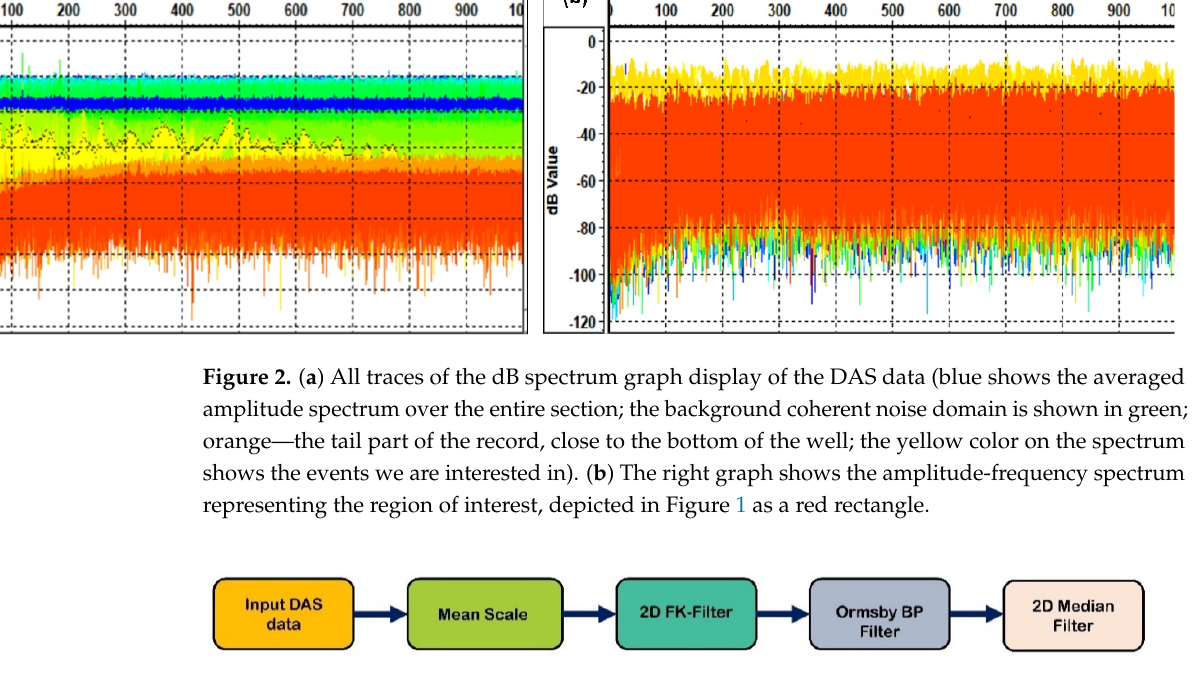
Figure 2. ( a ) All traces of the dB spectrum graph display of the DAS data (blue shows the averaged amplitude spectrum over the entire section; the background coherent noise domain is shown in green; orange—the tail part of the record, close to the bottom of the well; the yellow color on the spectrum shows the events we are interested in). ( b ) The right graph shows the amplitude-frequency spectrum representing the region of interest, depicted in Figure 1 as a red rectangle.